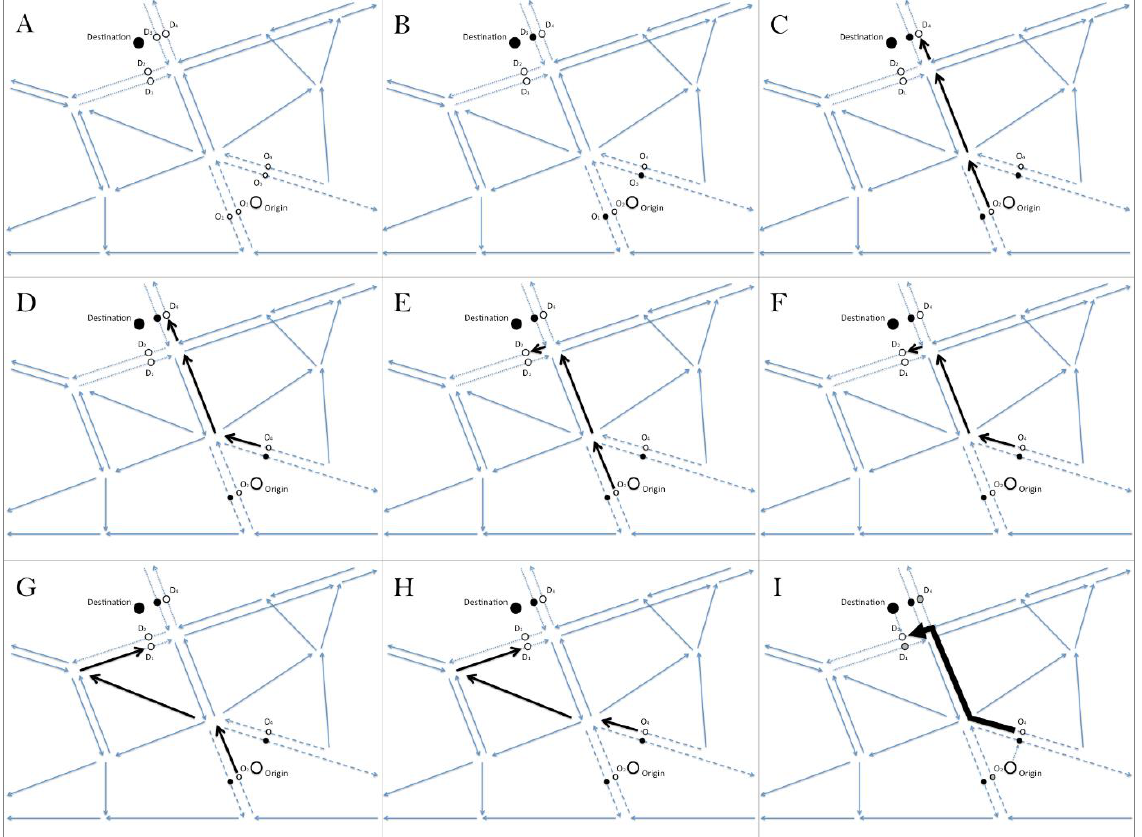
Figure 2. The combined map-matching and path inference process. For all pairs of successive GPS points (Origin-Destination 𝑃¹ → 𝑃² ) the proposed algorithm (1) finds all candidate start links 𝐶𝑠𝐿ⁿ and end links 𝐶𝑒𝐿ⁿ within the appropriate distance buffers 𝑏 𝐶𝑠𝑃ⁿ and 𝑅 𝑚 and calculates their respective candidate start end 𝐶𝑒𝑃ⁿ points (A); (2) identifies the on-network points that do not hold appropriate